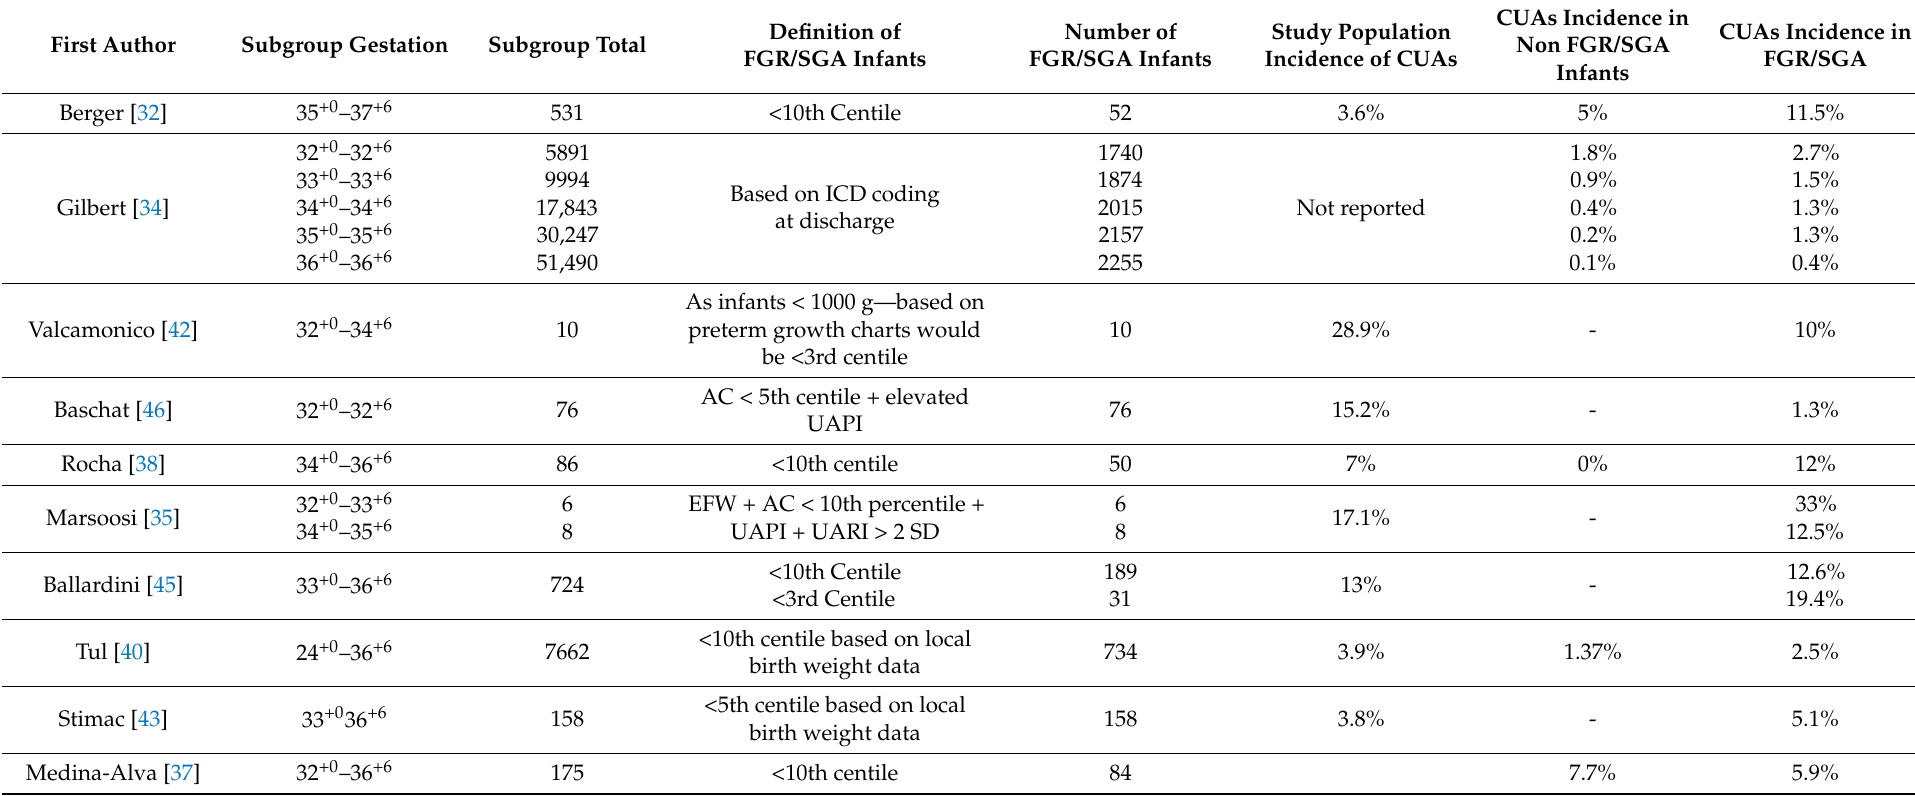
Table 4. Study Characteristics and Incidence of CUAs Reporting on Moderate-Late Preterm